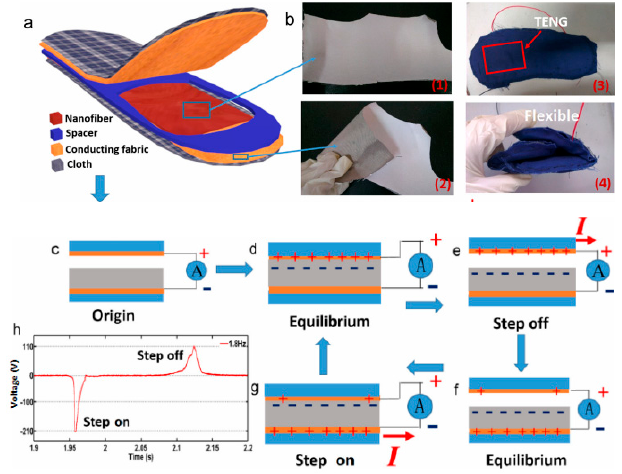
Figure 7. Schematic of a triboelectric nanogenerator based insole [80]. ( a ) TENG embedded into insole; ( b ) PVDF nanofibers; ( c – g ) working mechanism of the TENG when the device is in the states of origin, equilibrium, step off, equilibrium, step on; ( h ) voltage-time curve.